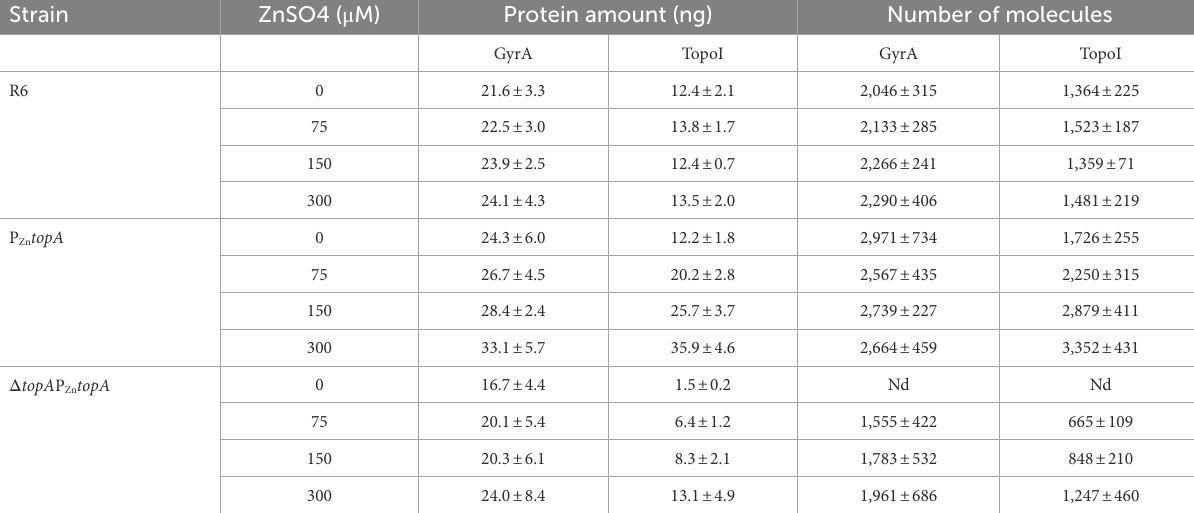
TABLE 2 Estimation of protein amounts and number of molecules for GyrA and TopoI. Strain